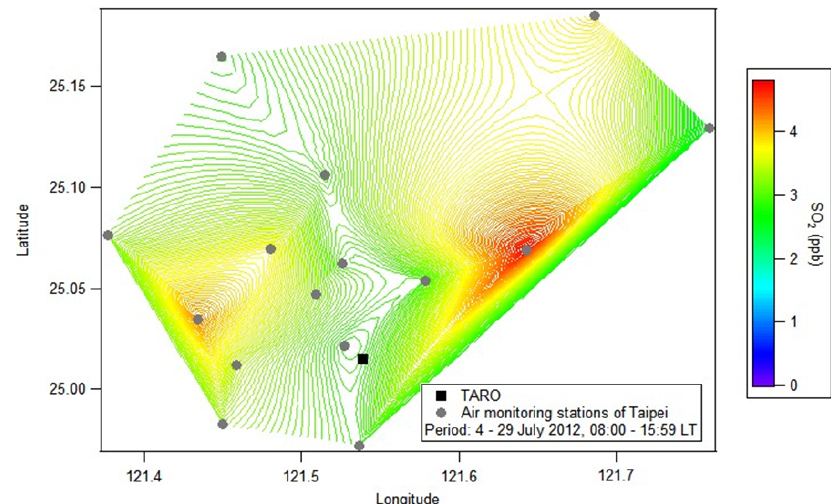
Fig. 8. Mean SO 2 mixing ratio of Taipei region measured during 4–29 July 2012. Square dot: TARO. Circle dots: air-quality monitoring stations of Taiwan EPA.